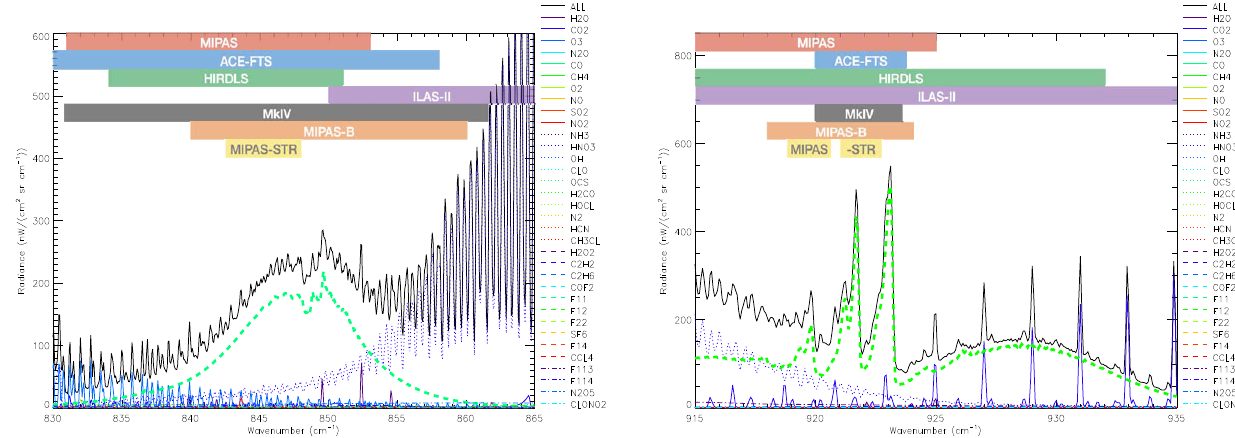
Figure 1. Simulated midlatitude emission spectra of the main regions of CFC-11 (left) and CFC-12 (right) at 20km in July. The spectral regions used for each instrument are shown. Only ILAS-2 uses a far wider range to retrieve CFC-11 and CFC-12.